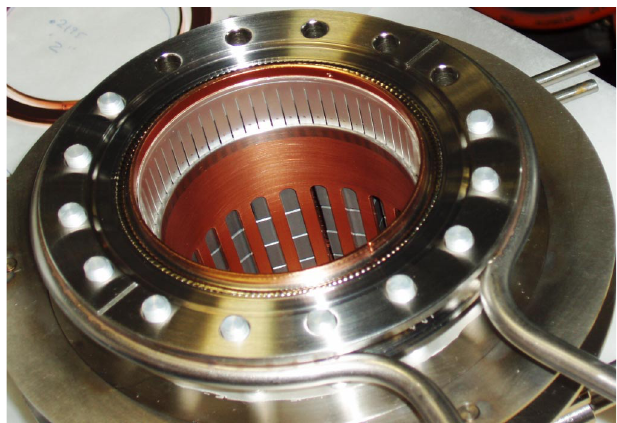
FIG. 15. (Color) Temperature rise in the downstream arc bellows (red) and LER current (green).